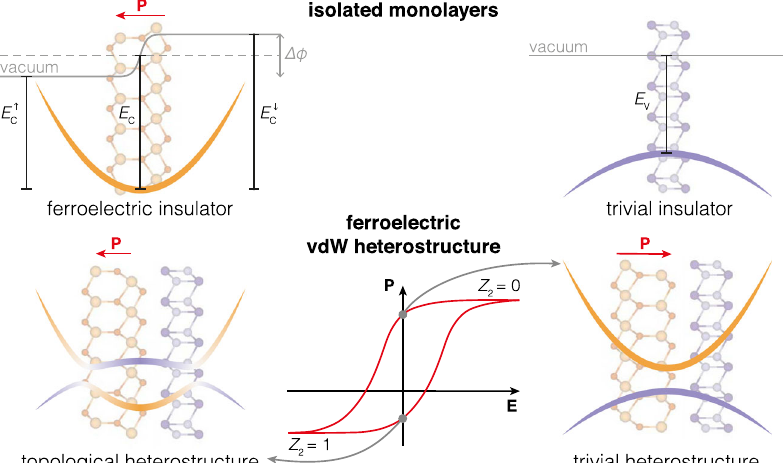
Fig. 1 Operating principles of ferroelectric control of topology in a van-der-Waals heterostructure. A two-dimensional (2D) ferroelectric insulator with fi nite out-of-plane polarization and a trivial 2D insulator are put together forming a van-der-Waals heterostructure. As a consequence of the fi nite vertical dipole, an electrostatic potential drop Δ ϕ exists across the ferroelectric layer, which shifts the vacuum level. Remarkably, it is possible to fi nd combinations of materials for which, upon the formation of the heterostructure, this difference in vacuum energy can give rise to distinct band alignments between the two layers depending on the polarization direction. In one polarization state the dipole-induced offset is such that a fi nite energy gap is present between the valence bands associated with the normal layer and the conduction bands arising from the ferroelectric material, so that the system is a trivial semiconductor. For the opposite polarization, a band inversion occurs and spin orbit interactions can open a fi nite gap between inverted bands, promoting the heterostructure to a quantum spin Hall insulator with a non-trivial Z 2 topological invariant. The difference between the two polarization states is re fl ected in an asymmetry of the hysteresis cycle, with a smaller magnitude of polarization in the topologically non-trivial state as a consequence of the charge transfer between the layers arising from the band